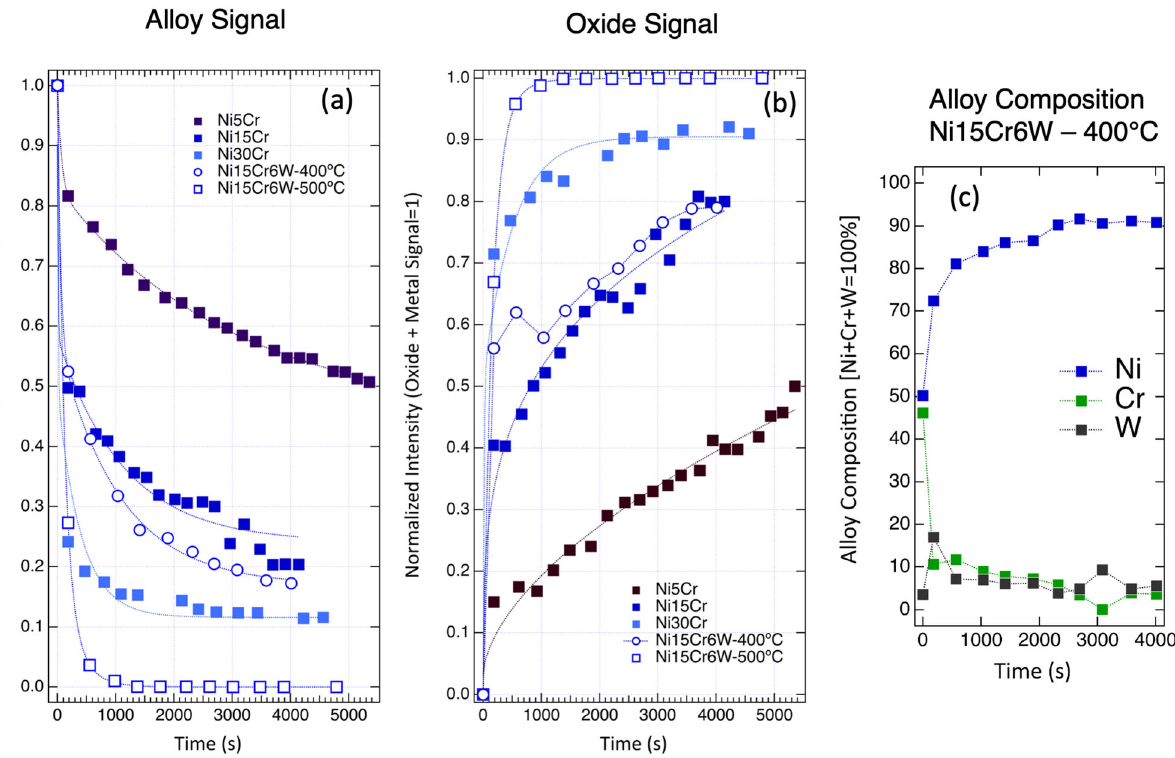
Fig. 4 Alloy and oxide evolution. a , b Decomposition of the Ni 2p 3/2 , and Cr 2p 3/2 core levels into alloy and oxide contributions for 4 alloys at 500 °C, and Ni-15Cr-6W at 400 °C, respectively. The sum of (alloy + oxide) signal is normalized to 1 to allow for direct comparison between all datasets. The relative contributions of alloy and oxide are determined from the fi t for each oxidation step, and all alloys studied. For all experiments at 500 °C no Cr is detected except for small contributions far below the bulk alloy levels in the fi rst two oxidation steps. c Alloy composition for Ni-15-6W oxidized at 400° C, which is the only alloy where Cr and W can still be detected in the vicinity of the alloy-oxide